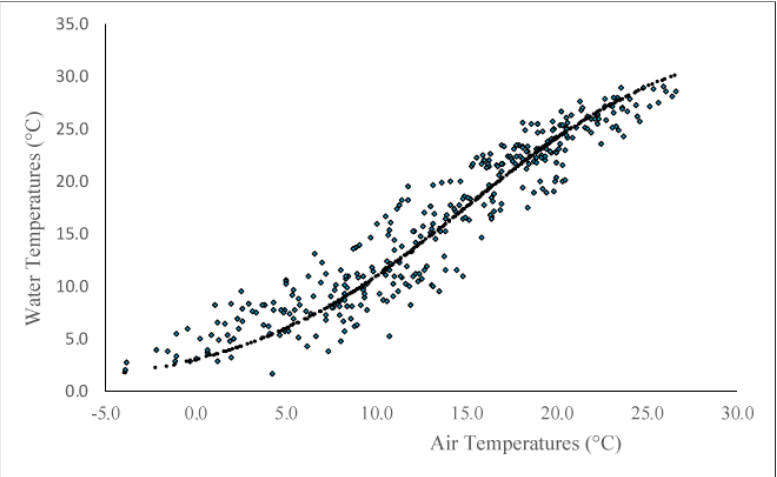
Figure 6. S-Shaped fit of 2018 daily mean water and air temperatures collected at the center of Thomas Pond